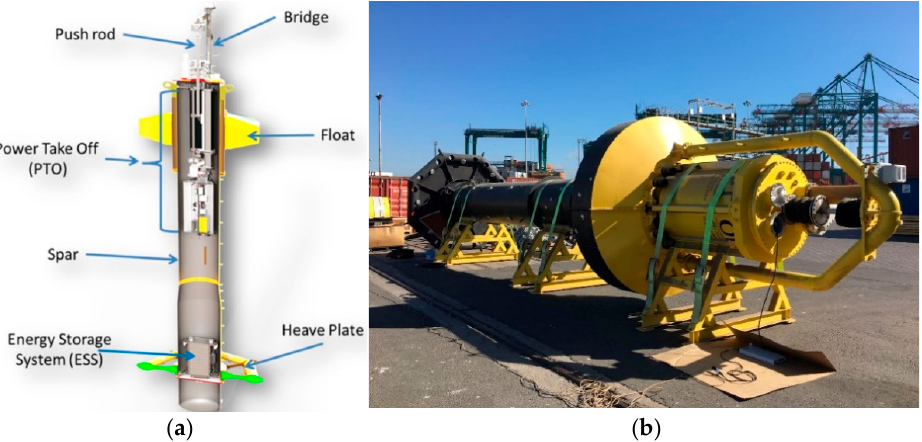
Figure 4. ( a ) Diagram with the main parts of the PB3 PowerBuoy, courtesy of Ocean Power Tech- nologies. ( b ) PB3 PowerBuoy on the preconditioning stage.